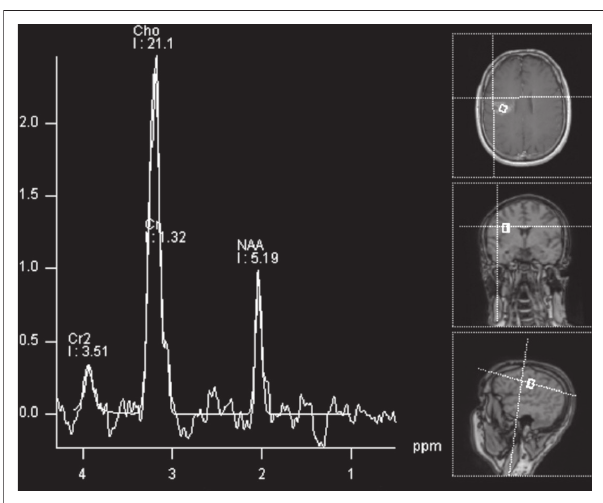
FIGURE 7: MR Spectroscopy image obtained at TE